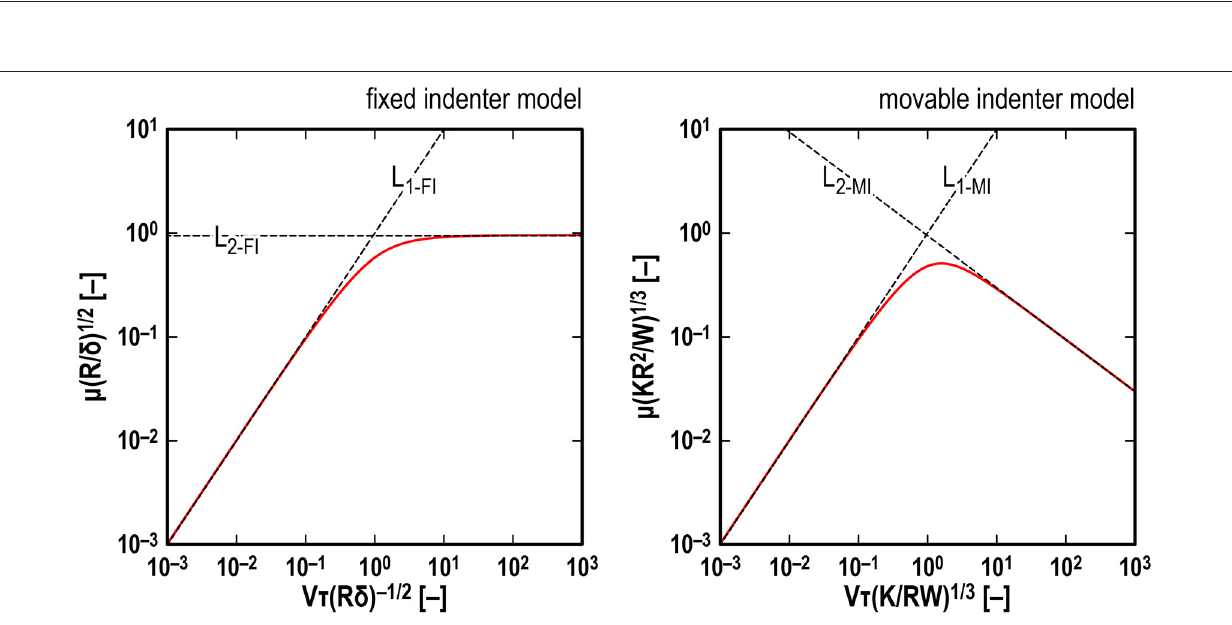
FIGURE 6 | Master curves on friction coefficient µ in steady sliding for fixed indenter model (Left) and movable indenter model (Right) . Red solid lines: master curves obtained numerically, black broken lines: asymptotes obtained theoretically.